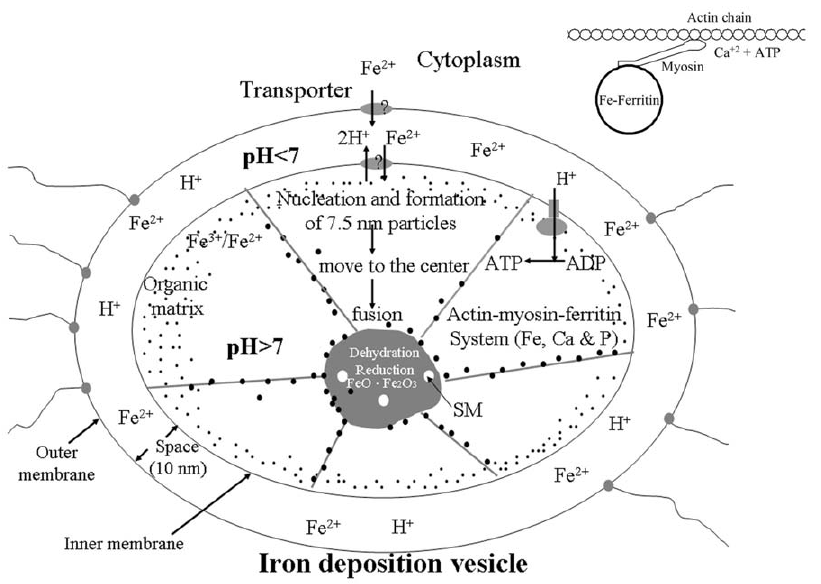
Figure 5. A hypothetical model of magnetite biomineralization in the IDVs of trophocytes. Inset shows the actin-myosin-ferritin transporter system. SM, superparamagnetic magnetite.